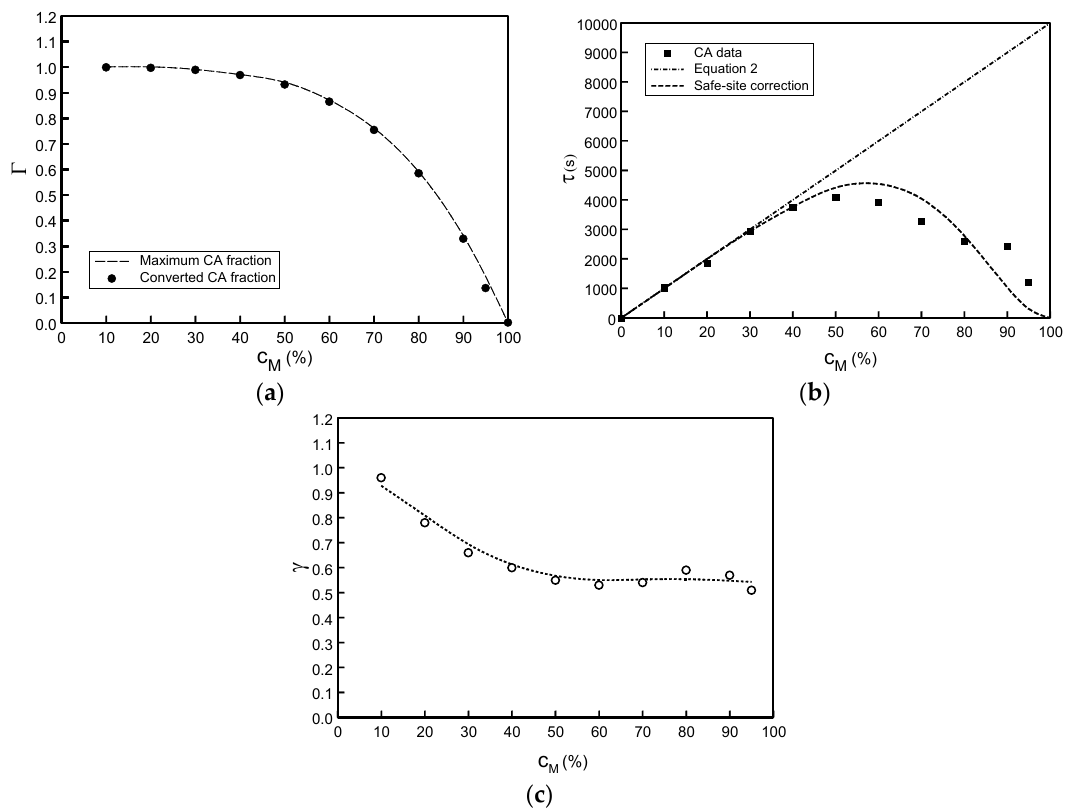
Figure 3. c M dependence of dynamical parameters (symbols) from CA data fitted using Equation (1): ( a ) Converted fraction Γ ; ( b ) Characteristic time constant τ ; ( c ) Stretched-exponential parameter γ